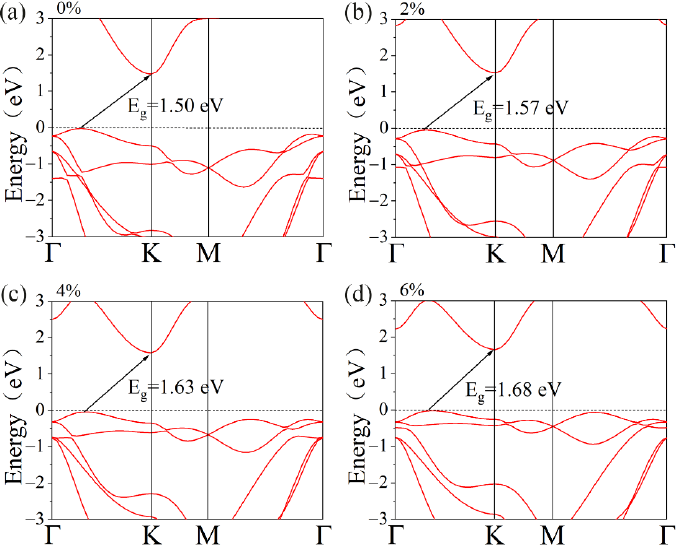
Figure 3. Band structures under different biaxial tensile strains of( a ) 0%, ( b ) 2%, ( c ) 4% and ( d ) 6% for GeS 2 monolayer .